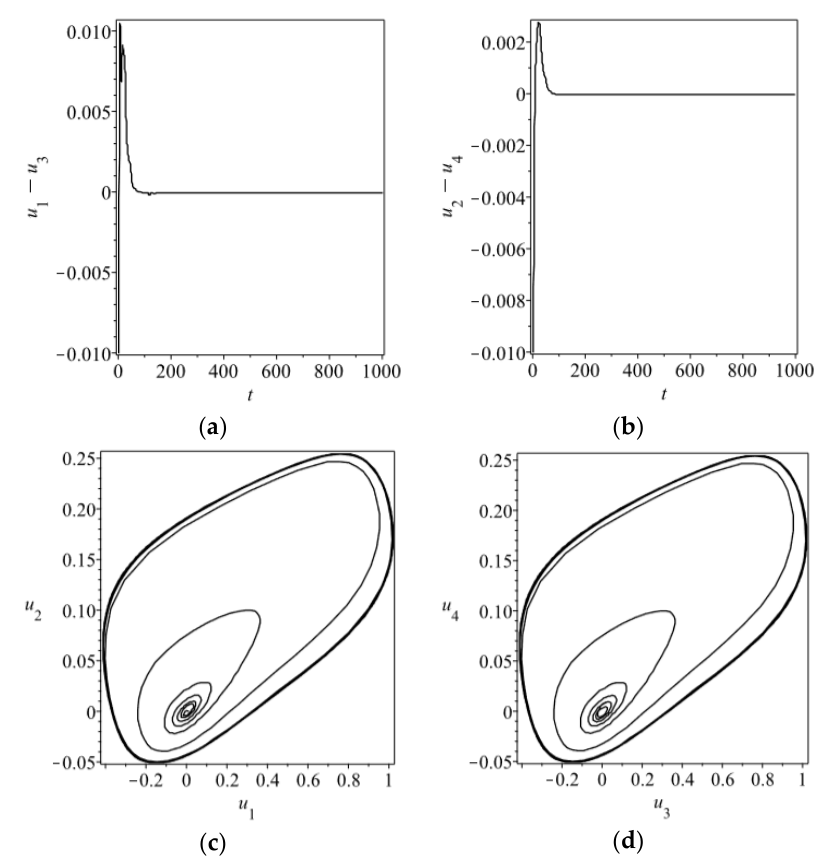
Figure 5. Synchronization errors ( a , b ) and phase diagrams ( c , d ) for Equation (12) with a = 0.1, b = 0.08, γ = 3, c = 0.18 and τ = 7. The initial conditions are chosen as u u 4 ( t − τ ) = 0.01, u 4 ( t − τ ) = 0.01 for t ∈ ( − τ ,0 ]